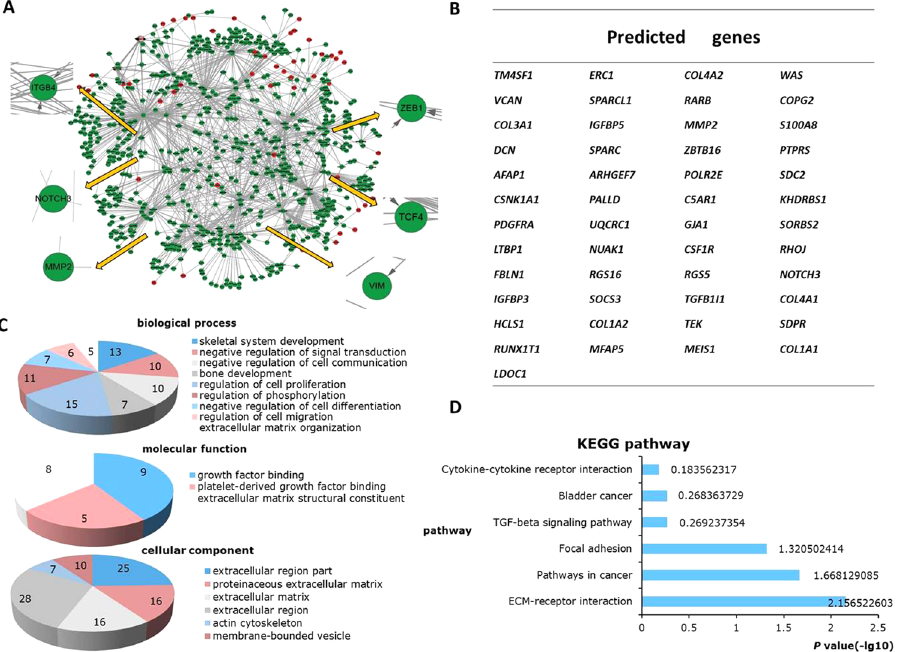
Figure 2. Data mining and functional analysis of differentially expressed genes in tumor bud. ( A ) Potential EMT biomarkers (red spots) selected from tumor the bud samples mapped on a classical EMT-regulator network (green spots) constructed with CFinder (the classical EMT regulators were from an online database) 43 . TCF4, VIM, ZEB1, ITGB3, NOTCH3, and MMP2, are the classical EMT biomarkers that were used to show the reliability of our data mining from the online database. ( B ) Forty-nine genes that functionally interacted with the classical EMT regulators, on the basis of the PPI network are shown in the three-line table. ( C , D ) GO and KEGG pathway analyses were used to identify the biological processes, molecular functions, cellular components and signaling pathways of the 49 genes ( P <